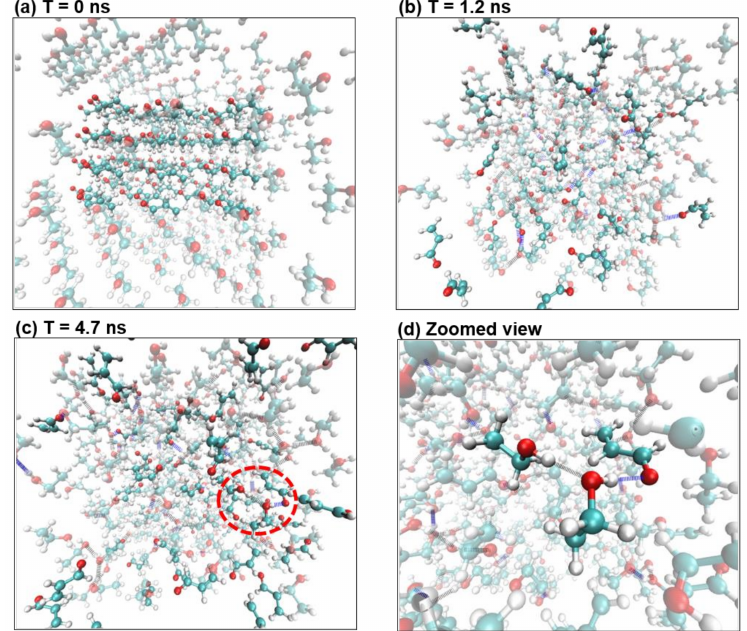
Figure 9. Acrolein molecules solvated in ethanol. In ( a – c ), the ethanol molecules are set to be transparent for a better view: ( a ) T = 0 ns; ( b ) T = 1.2 ns; ( c ) T = 5.4 ns; ( d ) the circled portion in ( c ), showing one acrolein connected to two ethanol molecules through hydrogen bonds. Color scheme: hydrogen in white, oxygen in red, carbon in cyan, blue for hydrogen bonds between waters and acrolein, and grey for hydrogen bonds between water molecules.